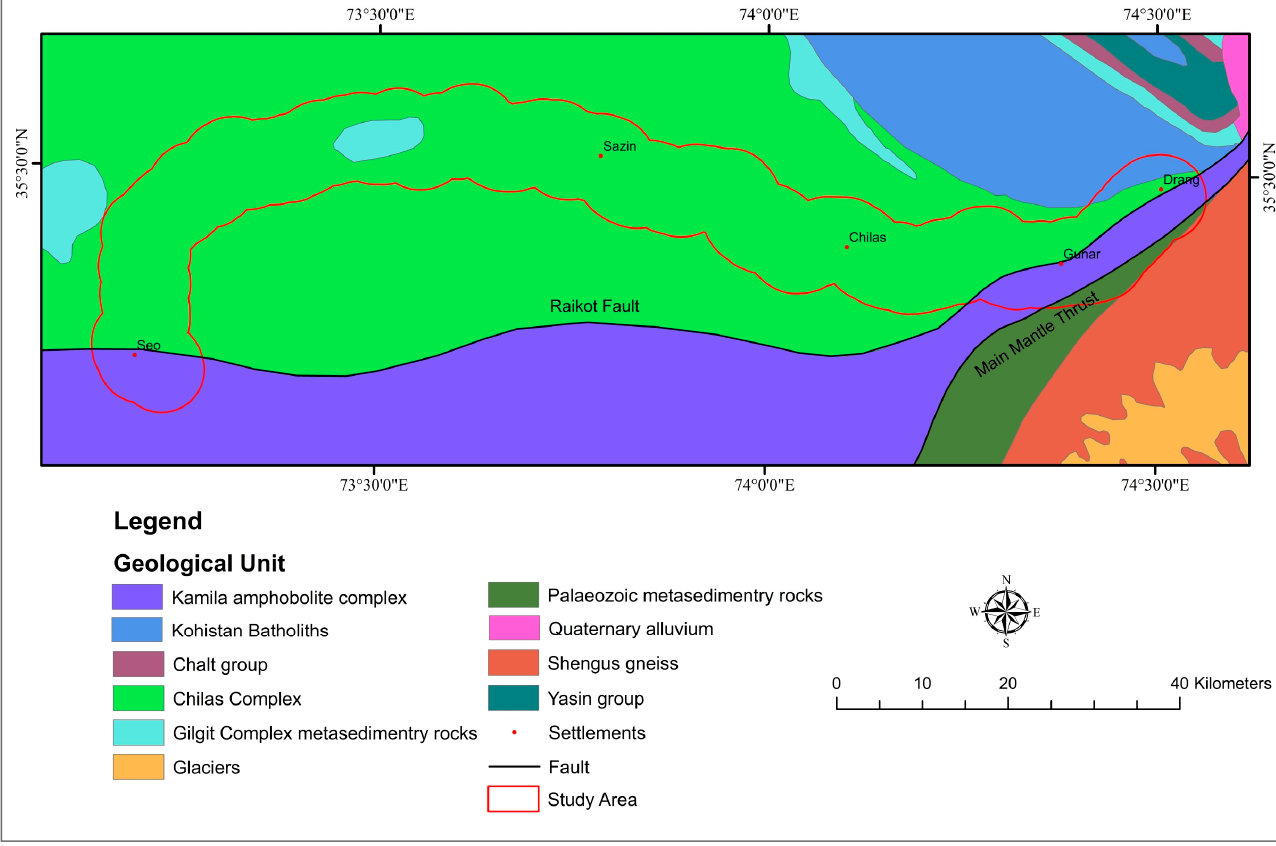
Figure 2 . Regional geological map of the study area. Figure 2. Regional geological map of the study area. Table 1. Information on landslide conditioning